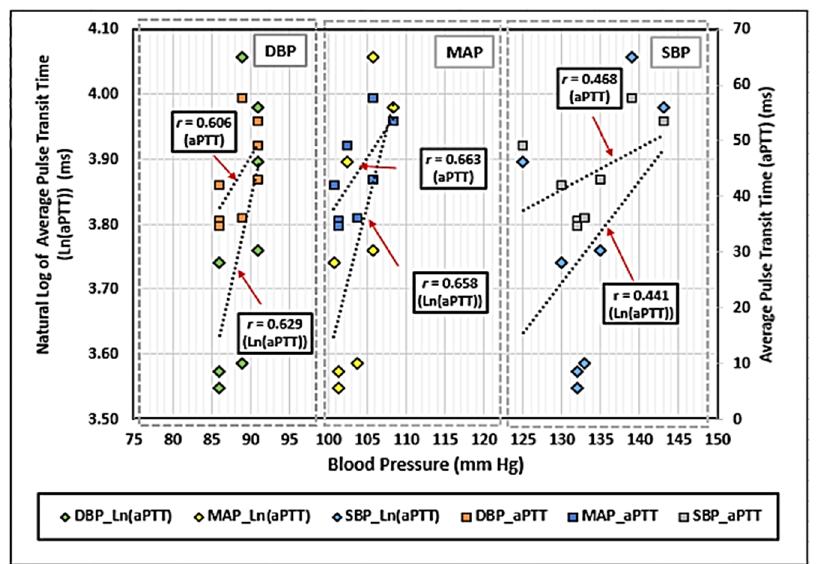
Figure 6. Plot of aPTT and Ln(aPTT) vs. BP where the ECG is extracted on the chest and the PPG on the wrist (test case 1 “TC ‐ 1”) (n = 8 trials).